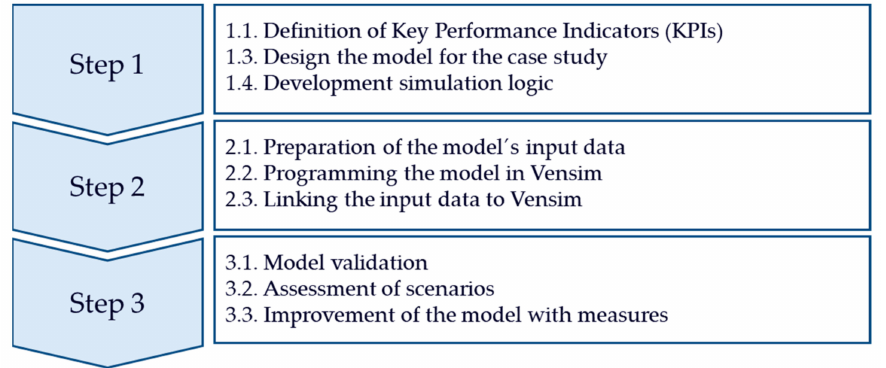
Figure 10. Simulation Design